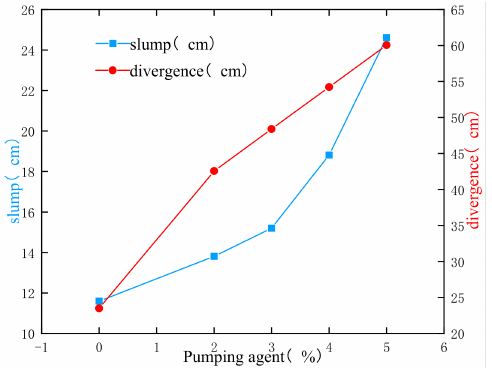
Figure 5. Amount of slump and expansion degree with different pumping agents added.